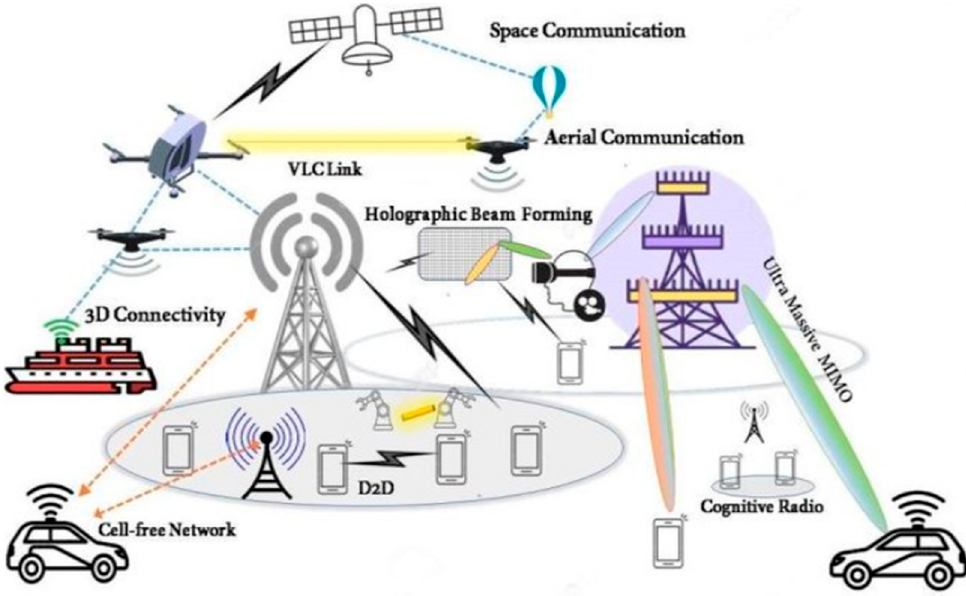
Figure 1. A sample of 6G expected infrastructure and applications.